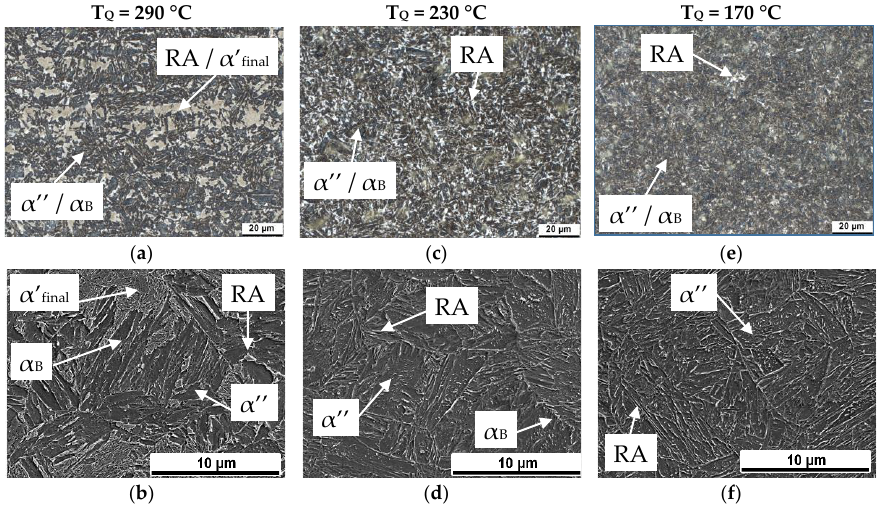
Figure 4. LOM and SEM micrographs of the Fe-C-3.5Mn-Si steel quenched to ( a , b ) T Q = 290 °C, ( c , d ) T Q = 230 °C and ( e , f ) T Q = 170 °C.